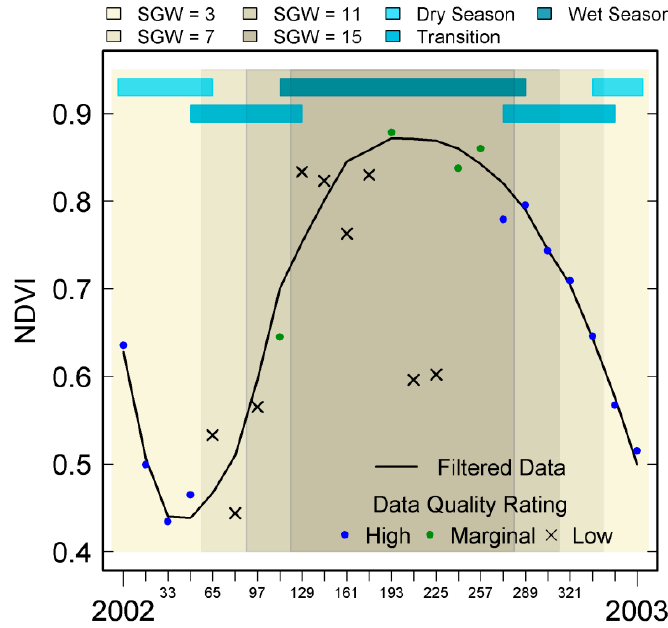
Figure A1. Description of the Seasonally Adjusted Savitsky–Golay filter. Seasons and season transitions are indicated by the horizontal blue bars. Savitsky–Golay window size (SGW) ranges from three observations during the dry season to 15 observations during the wet season.